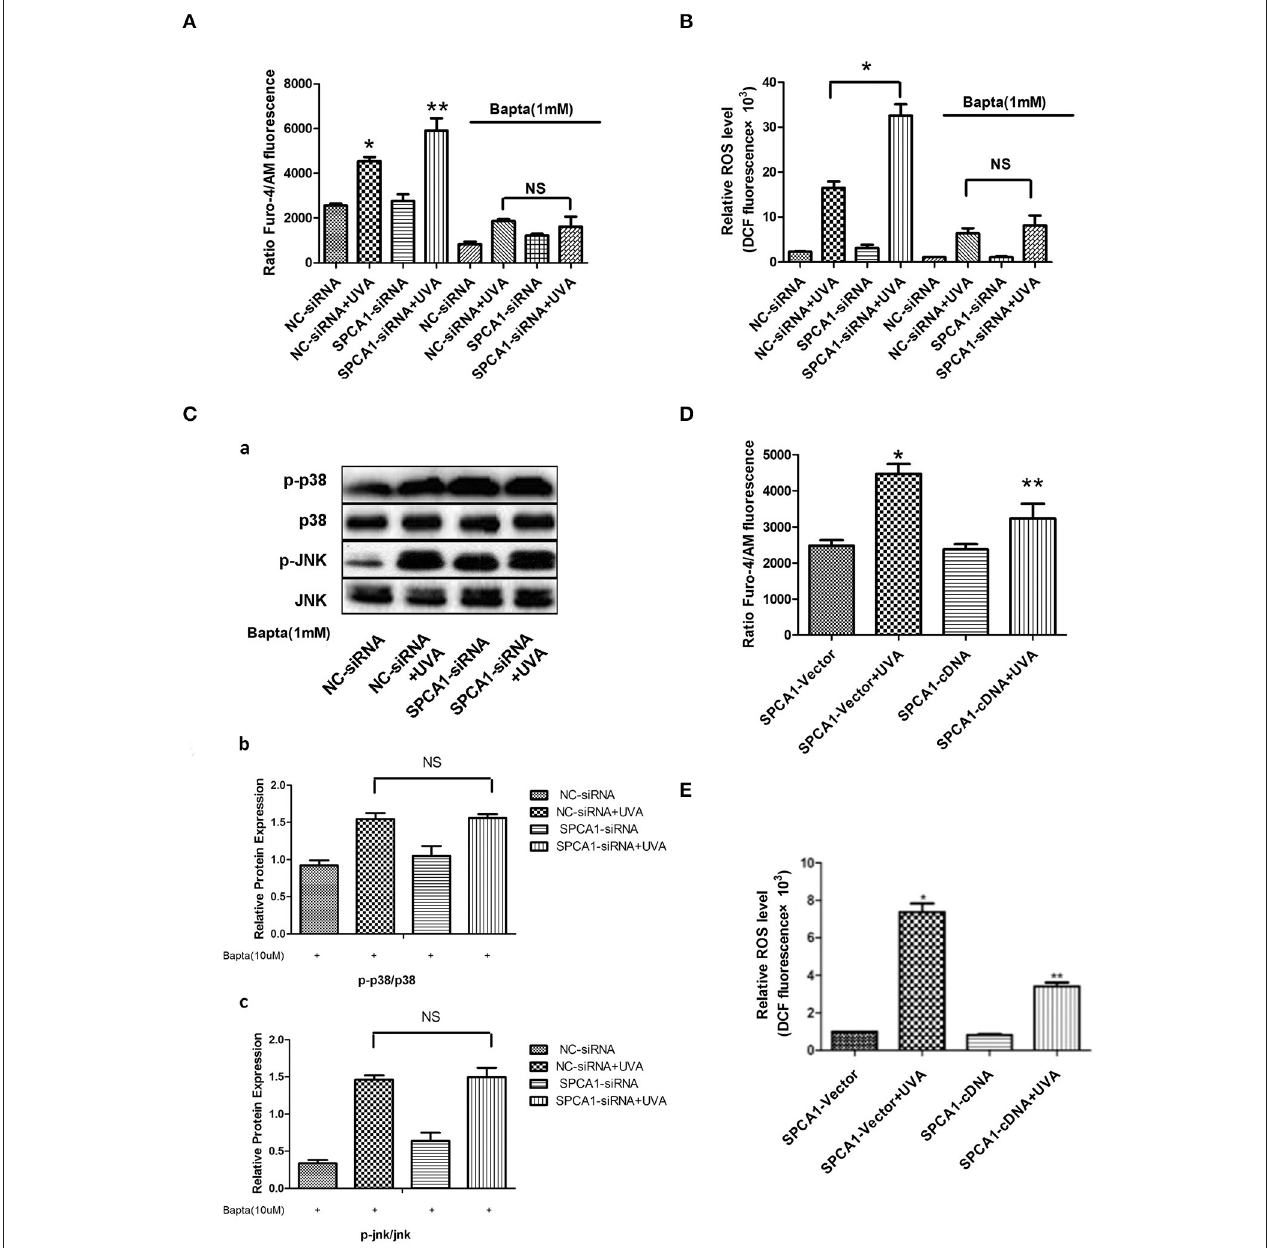
FIGURE 5 | SPCA1 affects UVA-induced ROS and MAPK activation via regulating [Ca 2 + ]i. (A) [Ca 2 + ]i levels determined by Fluo-4/AM fluorescence under indicated conditions. Bapta (1mM) abolish the effect of SPCA1 siRNA on [Ca 2 + ]i levels in UVA-irradiated HDF. * P < 0.05 vs. NC-siRNA; ** P < 0.05 vs. NC-siRNA + UVA; ns P < 0.05. (B) ROS levels determined by dichlorofluorescin diacetate fluorescence under indicated conditions. Bapta (1mM) abolish the effect of SPCA1 siRNA on ROS levels in UVA-irradiated HDF. * P < 0.05 vs. NC-siRNA; ** P < 0.05 vs. NC-siRNA + UVA; ns P < 0.05. (C) Western blot images and quantitative analysis show Bapta (1mM) abolish the effect of SPCA1 siRNA on phosphorylation of p38 and JNK in UVA-irradiated HDF. ns P < 0.05. Data are representative of three independent experiments. (D,E) [Ca 2 + ]i and ROS level in control and UVA-irradiated HDFs, with or without SPCA1 cDNA transfection. * P < 0.05 vs. SPCA1-vector; ** P < 0.05 vs. SPCA1-vector +